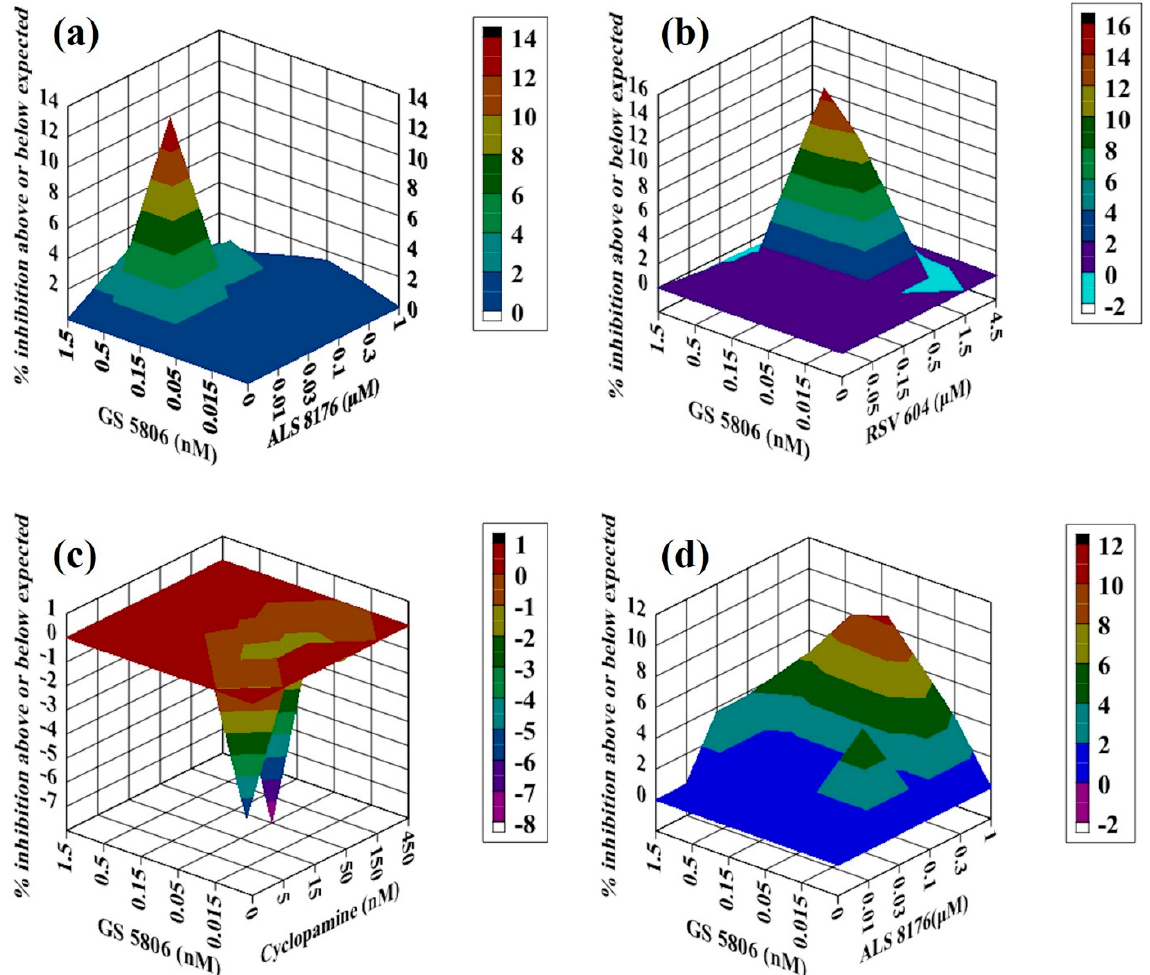
Figure 3. Analysis of compound interactions between RSV fusion inhibitor GS5806 and RdRp inhibitors in vitro. HEp-2 cells infected with RSV-Luc were subjected to serial dilutions of GS5806 (( a – d ); 0.015–1.5 nM), ALS8176 (( a , d ); 0.01–1 µM), RSV604 ( b ); 0.05–4.5 µM), or CPM ( c ); 5–450 nM) in a checkerboard method, and results were obtained via a luciferase activity reduction assay ( a – c ) or qPCR ( d ). Data shown were obtained using Macsynergy II program at 95% confidence interval and plotted with Delta Graph, and values on the Z-axis represent the mode of interaction between two selected compounds (>0, synergistic effect; <0, antagonistic effect; 0, additive effect). All data points represent averages of three measurements from three experiments.